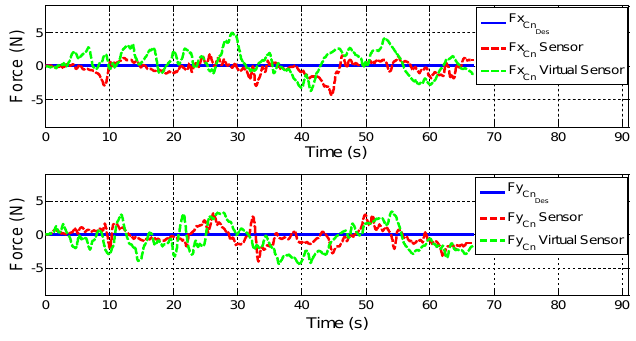
Figure 9. Validation of the Force Virtual Sensor in the ARM operating mode with zero force reference.